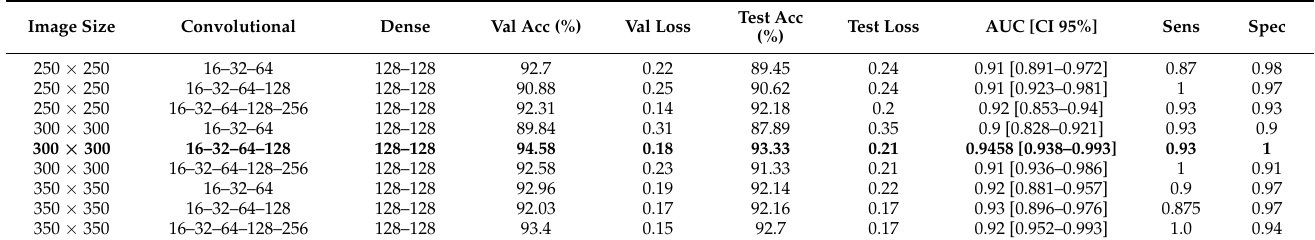
Table 3. Demonstration of exploration for determining the best RGB-CNN model.